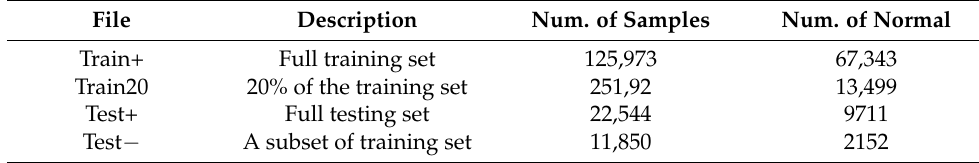
Table 3. NSL-KDD training and testing dataset files